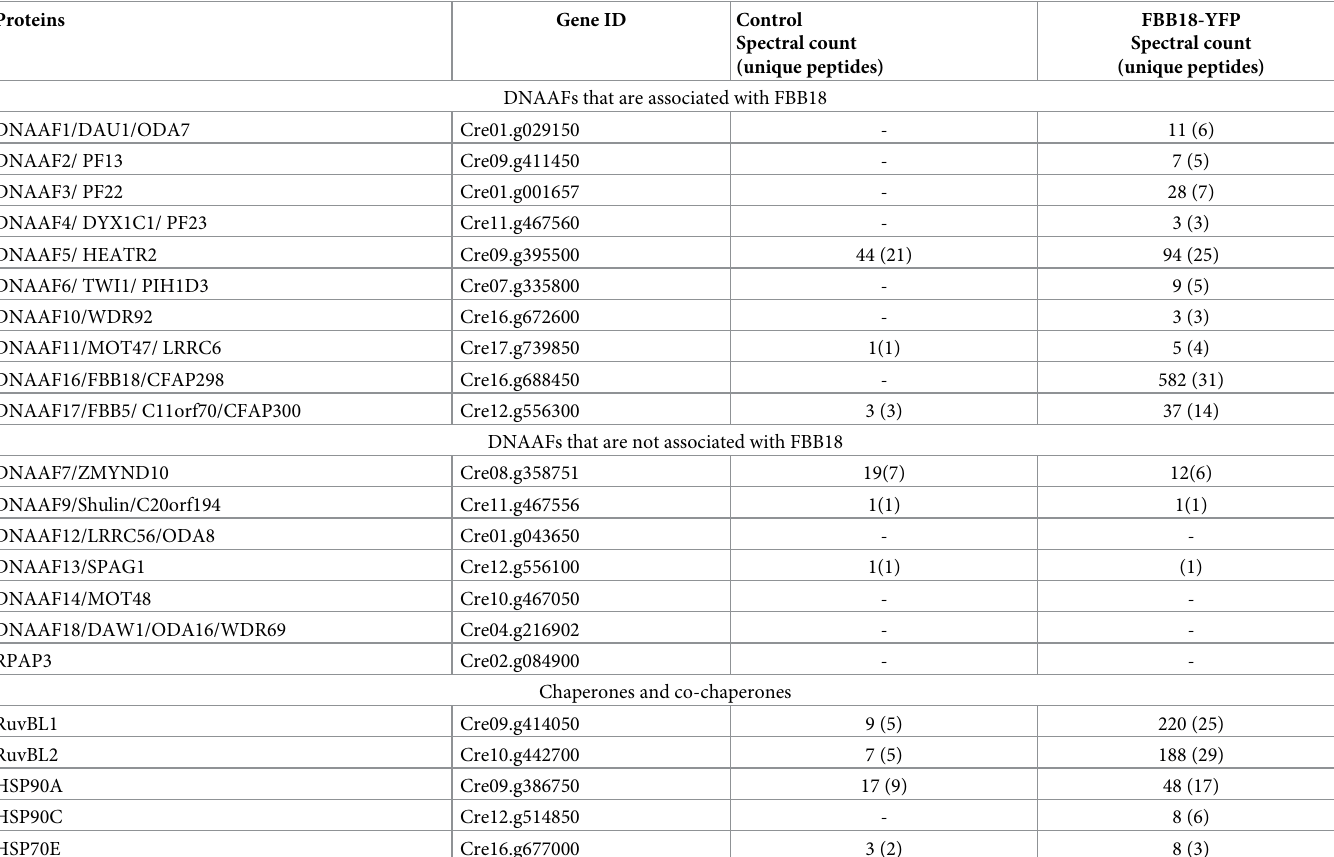
Immunoprecipitates from cells expressing FBB18 : YFP-TG or control cells with anti-GFP antibody were analyzed by mass spectrometry. Known dynein preassembly factors, R2TP components and chaperones were searched in the data set and their abundances are presented. Please note that the homologues of DNAAF8 and 15 are not present in the Chlamydomonas proteome. RPAP3 forms a R2TP complex with DNAAF14 and RuvBL1/2 and is thus being considered as a possible DNAAF (PMID: